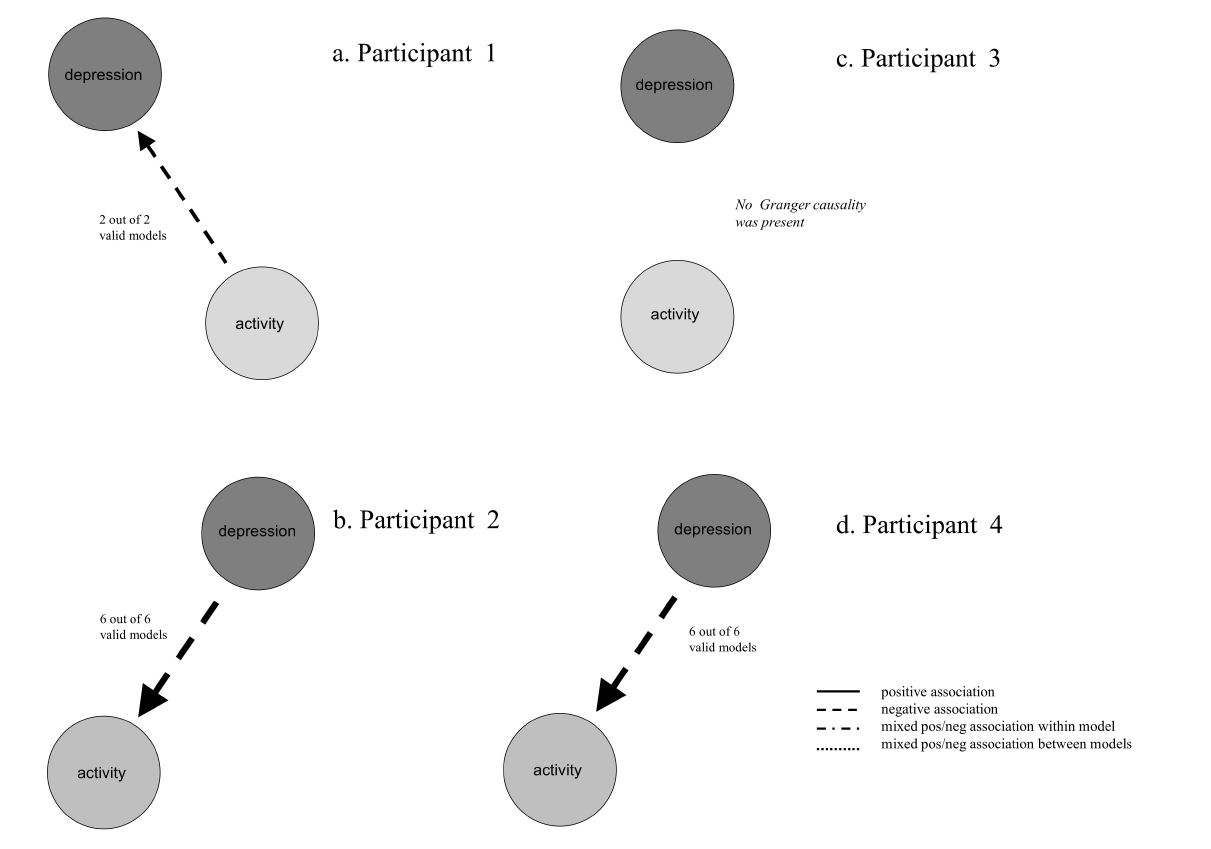
Figure 3. Granger causality